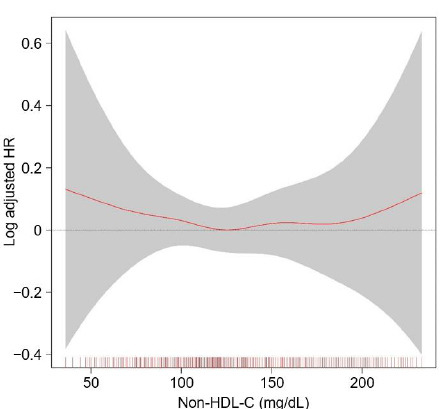
Figure 3. Restricted cubic spline of nHDL on composite renal event. Adjusted HR of nHDL as a continuous variable for a composite CV event is depicted. The model was adjusted for age and sex, age-adjusted Charlson comorbidity index, primary cause of CKD, smoking history, medication (angiotensin-converting enzyme inhibitors/angiotensin receptor blockers, diuretic use, number of antihypertensive drugs, statins), body mass index, waist circumference, systolic blood pressure, hemoglobin, albumin, fasting glucose, hs-CRP, CKD stage, and spot urine ACR. Abbreviations: CI, confidence interval; HR, hazard ratio; nHDL, non-high-density lipoprotein cholesterol; CV, cardiovascular; CKD, chronic kidney disease; hs-CRP, high-sensitivity C-reactive protein; ACR, albumin-to-creatinine ratio.